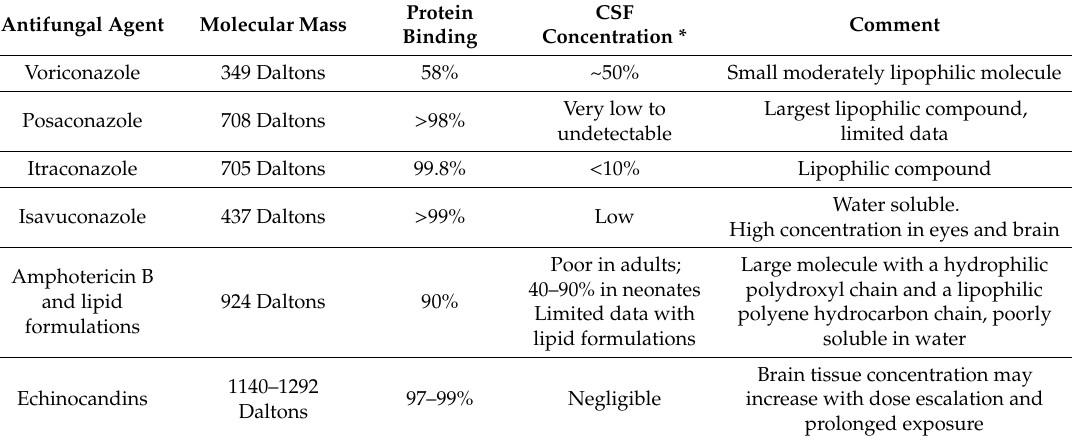
Table 1. Antifungal agents and central nervous system